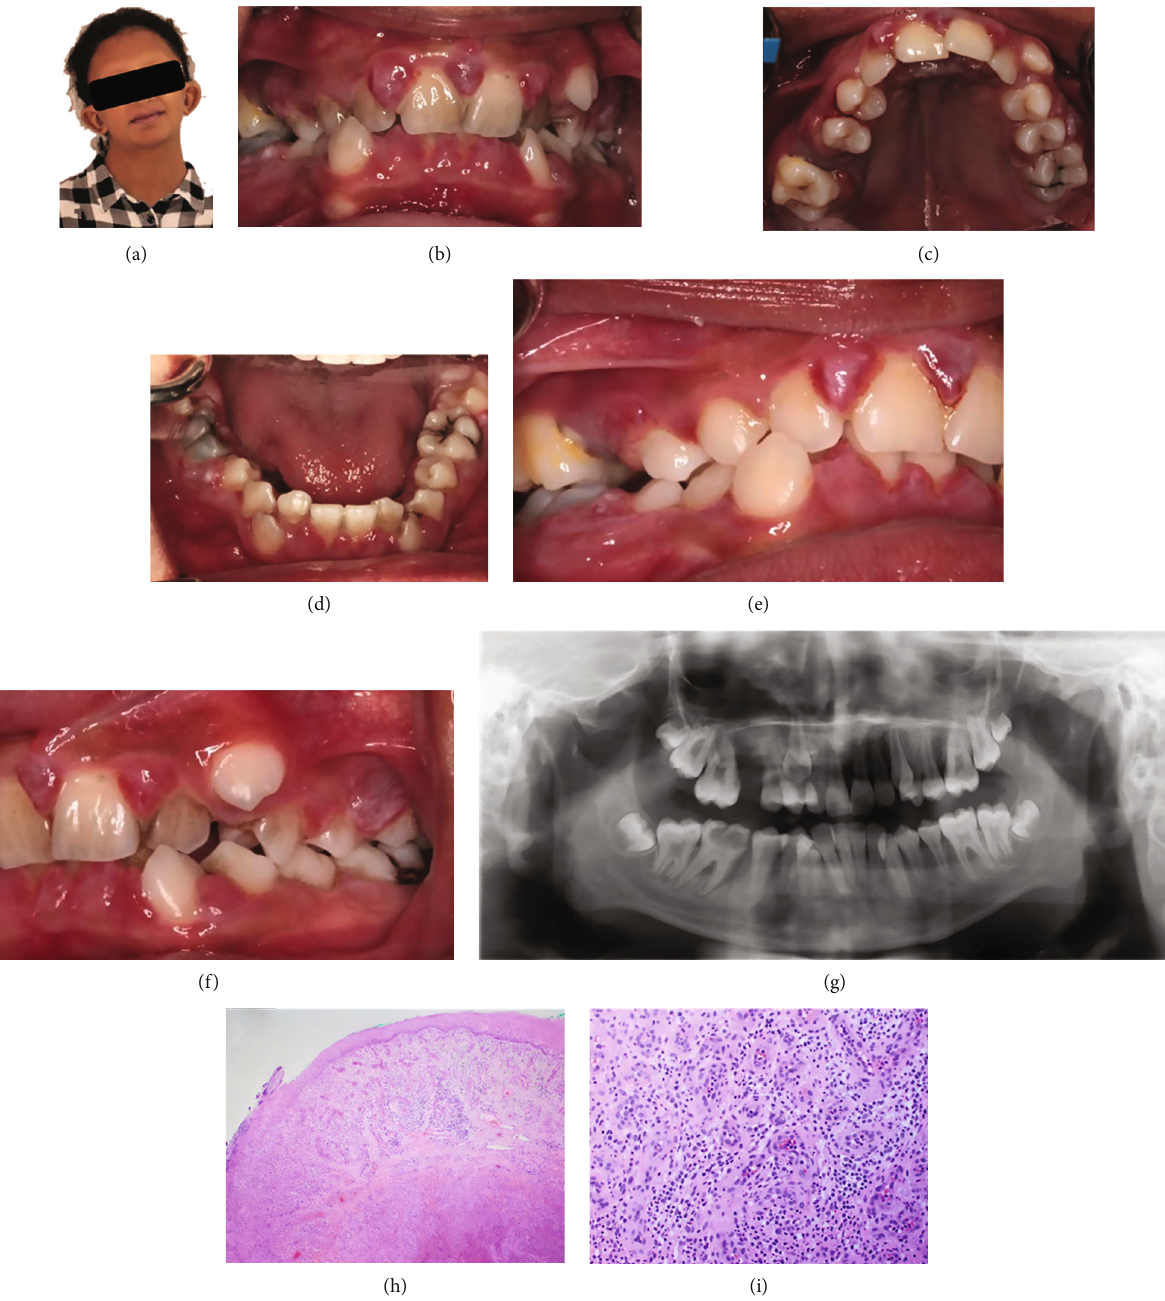
Figure 1: (a) Extra-oral frontal view at presentation. (b) – (f) Intra-oral views at presentation. (g) Orthopantomogram at presentation. (h) and (i) Hematoxylin & eosin stained images of fi rst excisional biopsy of gingival lesion palatal to teeth #8 and #9. (h) Photomicrograph depicting surface squamous mucosa exhibiting focal ulceration, and underlying submucosal proliferation of capillary sized blood vessels with lobular arrangement ( × 40). (i) High power view showing proliferation of capillaries admixed with numerous mononuclear and polymorphonuclear in fl ammatory cells ( ×